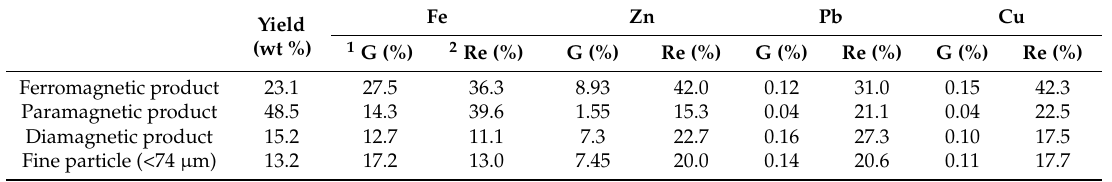
Table 5. Results of pre-concentration process of target